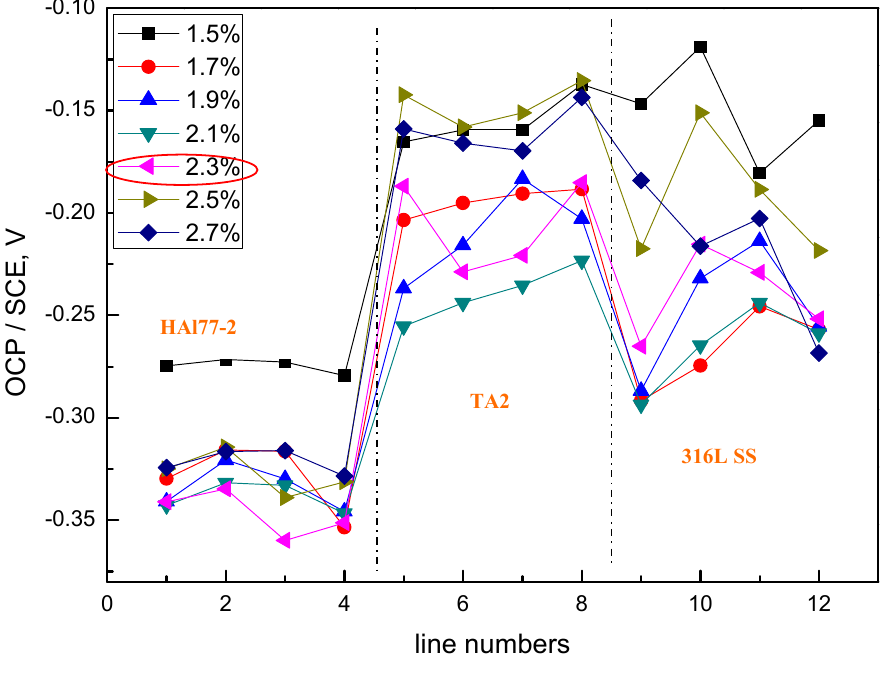
Figure 8. Average OCP potential values of each microelectrode line for CMEA2 after immersion in artificial seawater with different concentrations of chloride ions (wt %).